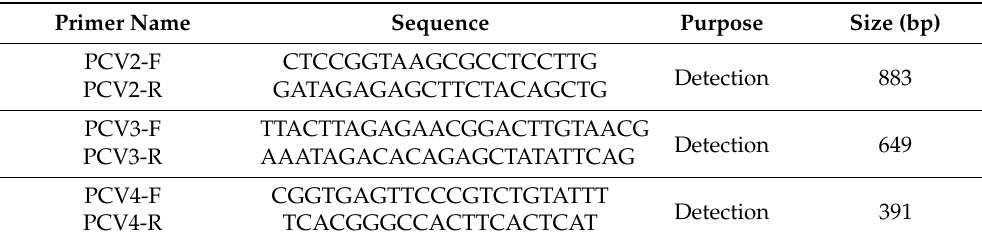
Table 1. Primers used in this